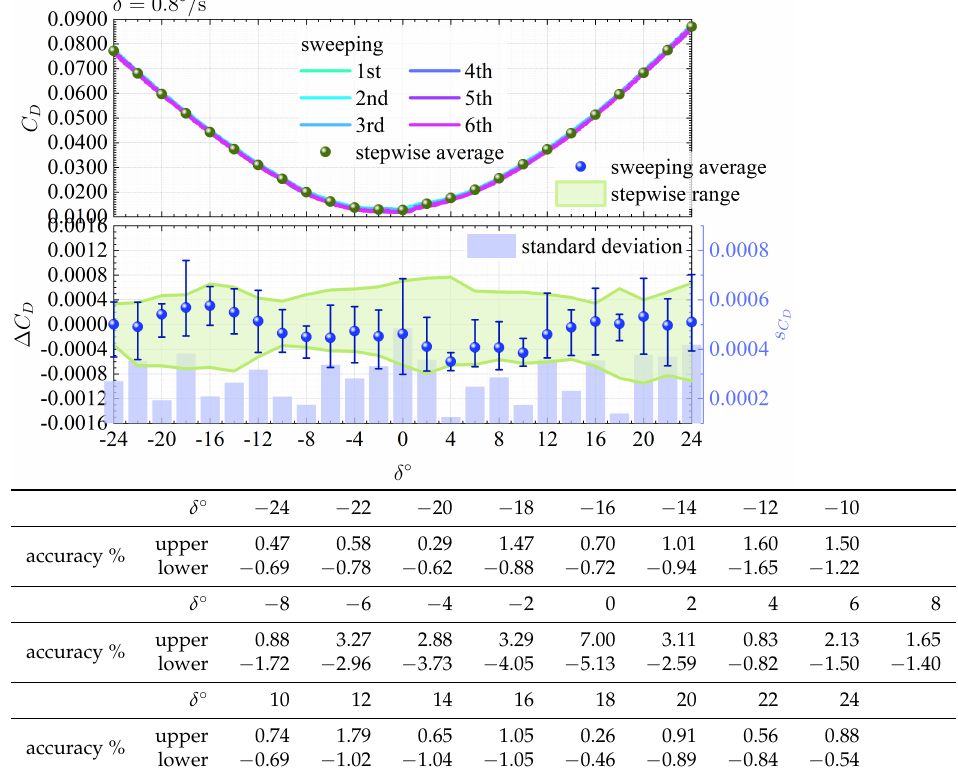
Figure 5. The results from a preliminary attempt in the sweeping mode under the conditions of ˙ δ = 0.8 ◦ /s, U ∞ = 40 m/s, and α = 0 ◦ compared with that in the stepwise